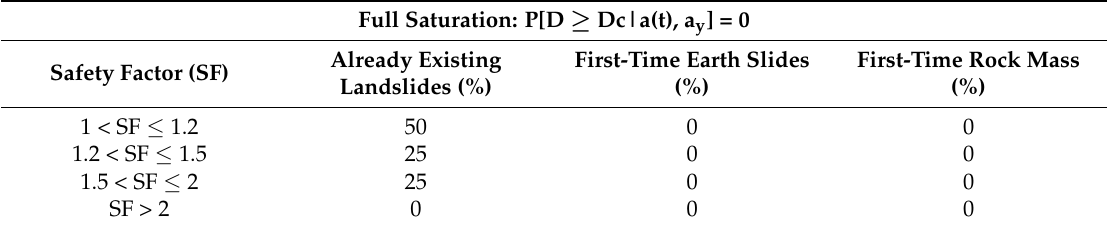
Table 9. Safety factor values computed in the full saturations scenario for different landslide typologies.